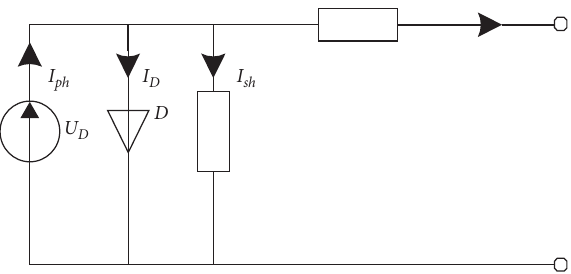
Figure 2: Equivalent circuit of the photovoltaic